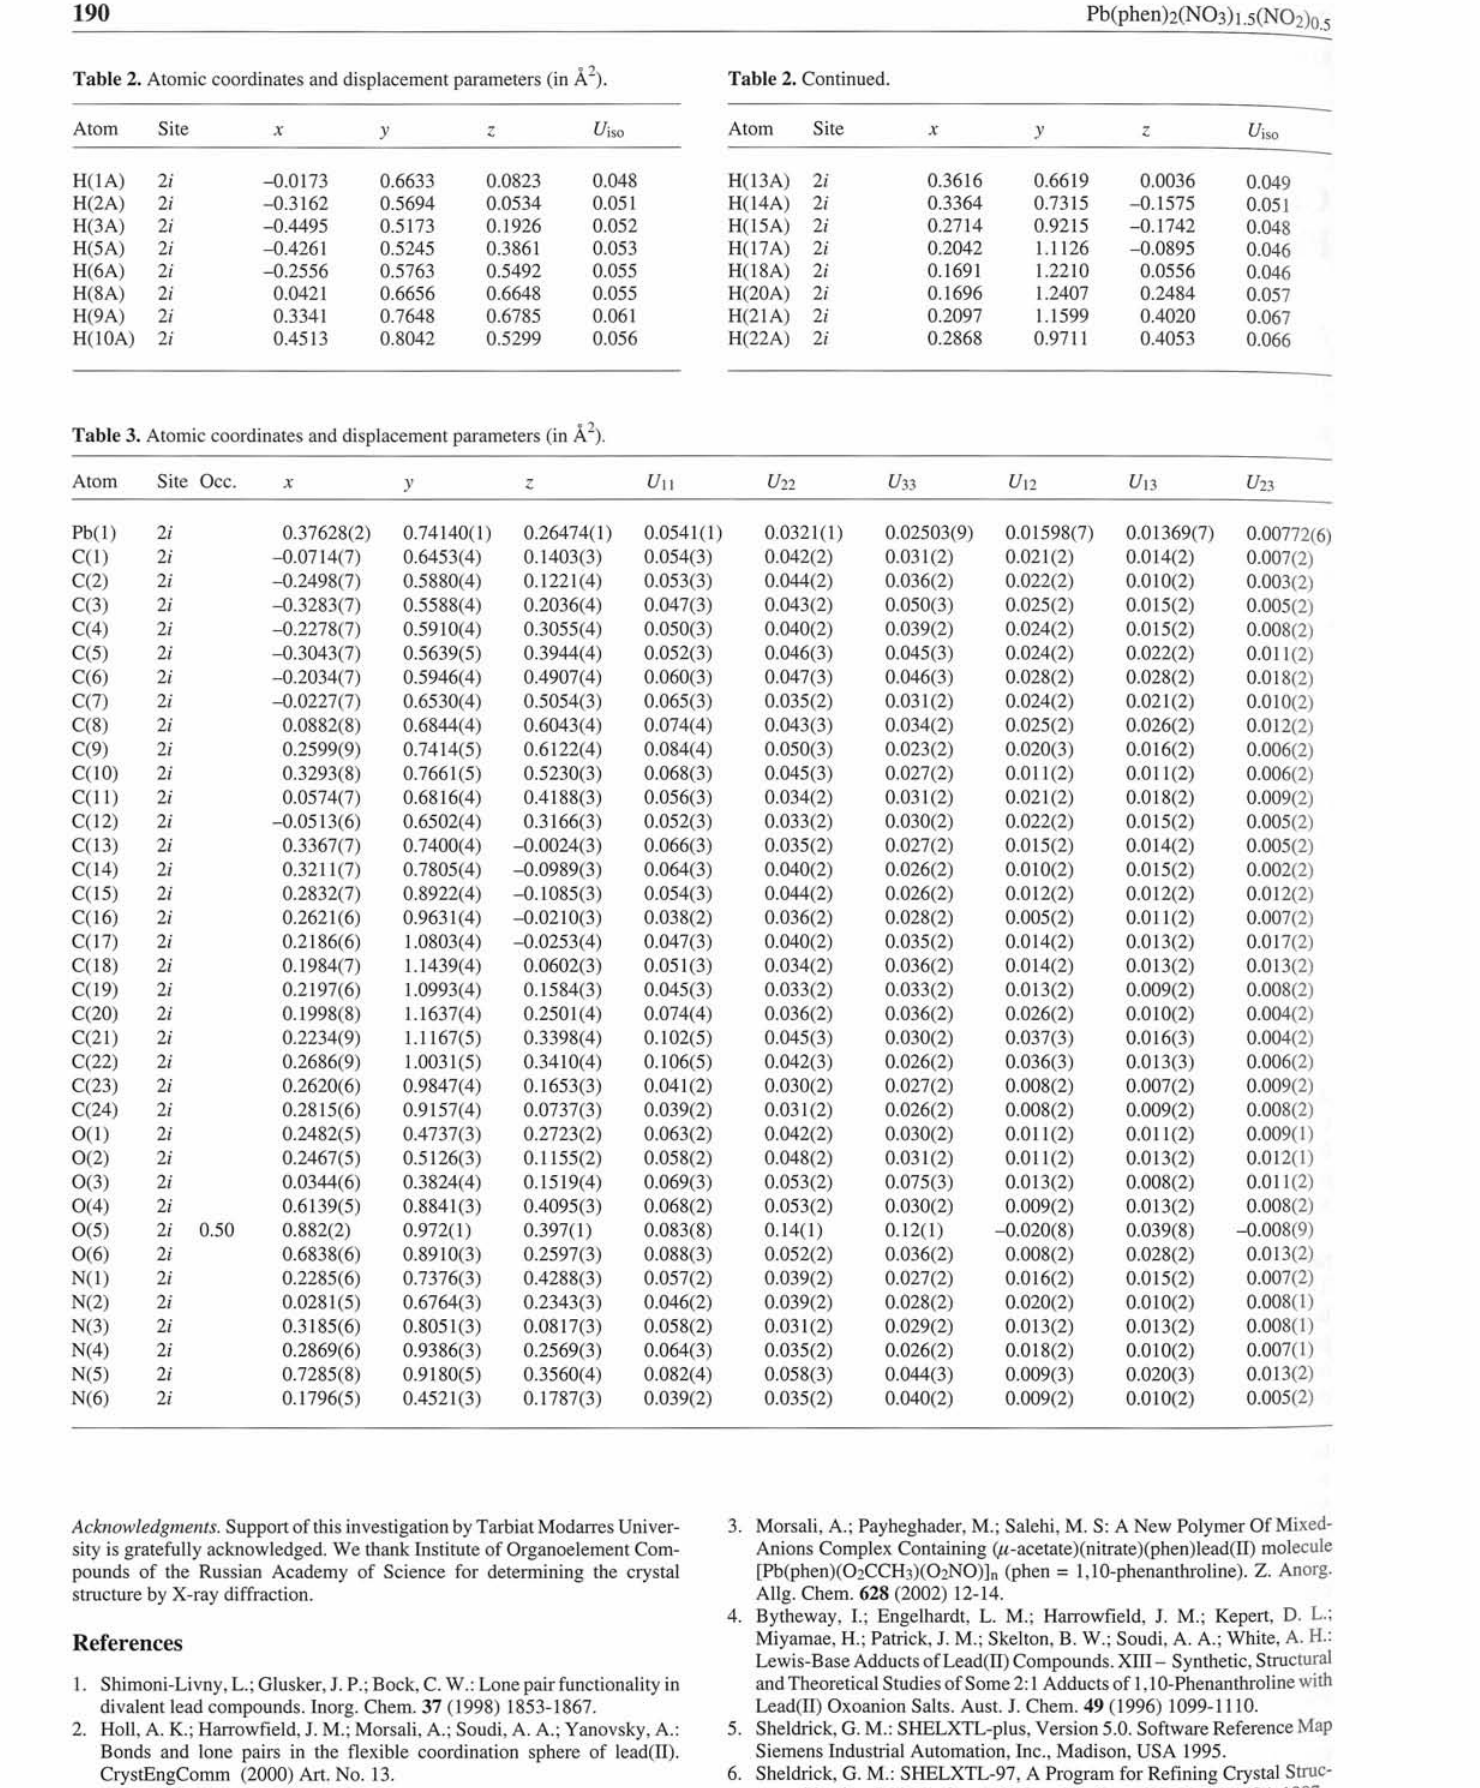
Table 3. Atomic coordinates and displacement parameters (in À 2